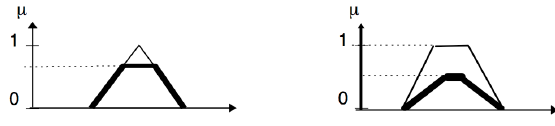
Fig. 3. Activation methods: Min (left) and Prod (right).